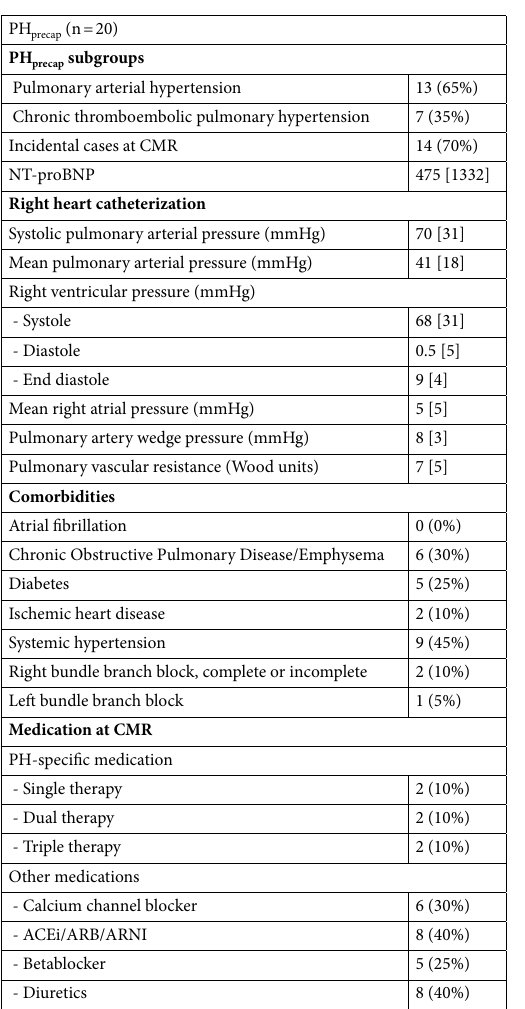
Right bundle branch block, complete or